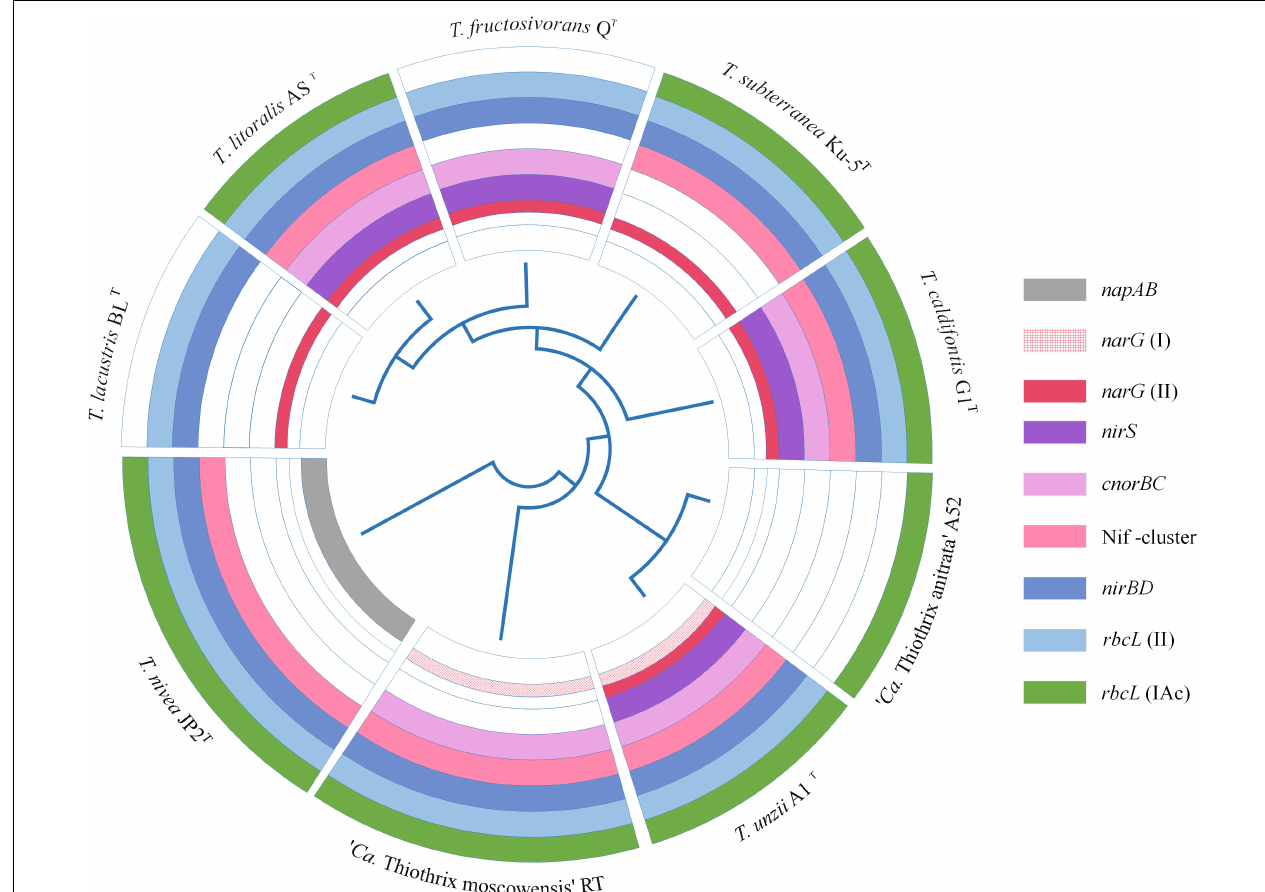
FIGURE 5 | The presence of genes for nitrogen metabolism and various types of RuBisCO in the genomes of Thiothrix sp. Dissimilatory nitrate reduction and nitrogen assimilation genes: napAB, periplasmic nitrate reductase; narG, membrane-bound nitrate reductase; nirS, nitrite reductase; cnorB, NO-reductase; nirBD, ammonia forming assimilatory nitrite reductase; nifDKH, nitrogenase genes; rbcL (II) and rbcL (IAc), genes encoding the large subunit of